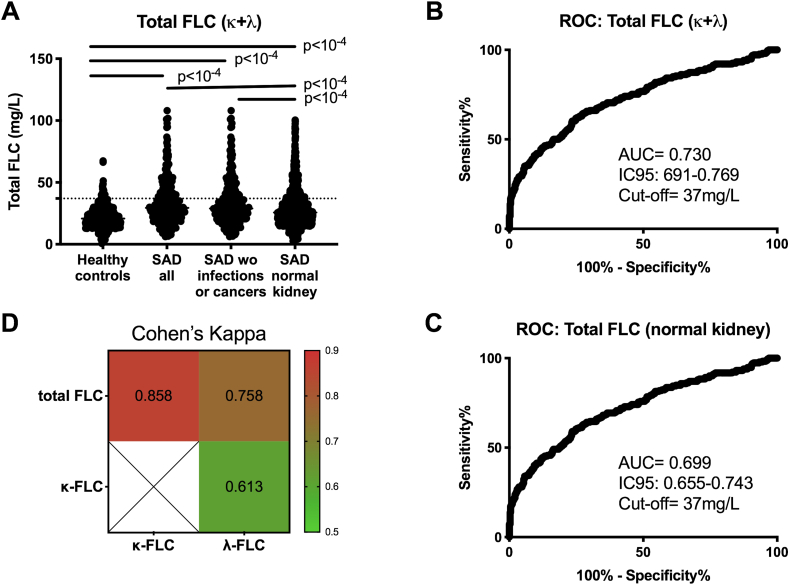
Free light chain (FLC) levels are elevated in systemic autoimmune diseases (SAD). A. Serum levels for total FLC (FLC-κ+λ) in controls (n ​= ​614), SAD patients (n ​= ​1979) and within the subgroups of SAD patients without infection and/or a history of cancer (n ​= ​1782), and with normal kidney function (n ​= ​1274). The dotted lines represent the selected cut-off fixed at 95% specificity: 37 ​mg/L for total FLC. B: ROC curves were performed in controls and SAD in order to determine the area under the curve (AUC) and cut-off values (95% specificity). C: ROC curves showing similar AUC characteristics when the SAD patient subgroup without renal impairment was selected instead of all SAD patients. D: Concordance assessment between total FLC (FLC-κ+λ), FLC kappa (FLC-κ), and FLC lambda (FLC-λ) using the Kappa coefficient of Cohen.